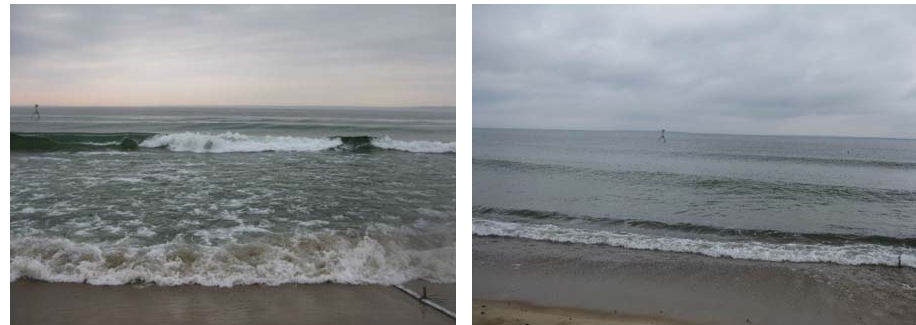
Fig. 2. High-speed vessel wakes at the Pikakari beach, Tallinn Bay, Baltic